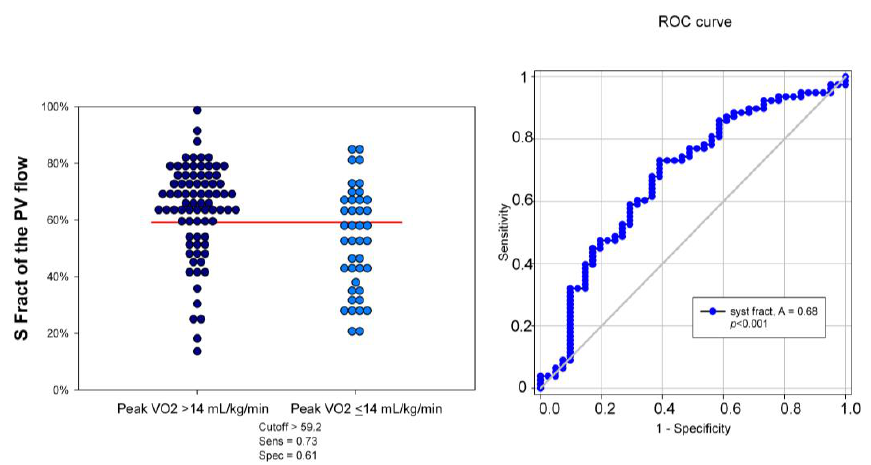
Figure 5. Dot histogram and ROC curve of S Fract in predicting the peak VO2 > and ≤ 14 mL/kg/min. The best S Fract cutoff was found at 59%, with an area under the curve of 68%, p < 0.001. Sens = sensitivity; Spec = specificity; S Fract = systolic fraction; PVF = pulmonary venous